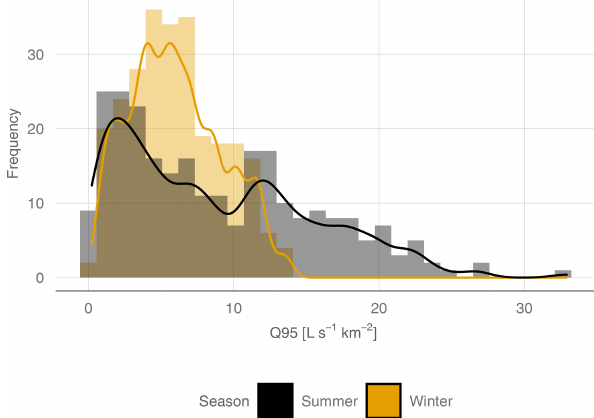
Figure 2. Absolute frequency (histogram and kernel density esti- mate) of summer q 95 and winter q 95 for all 260